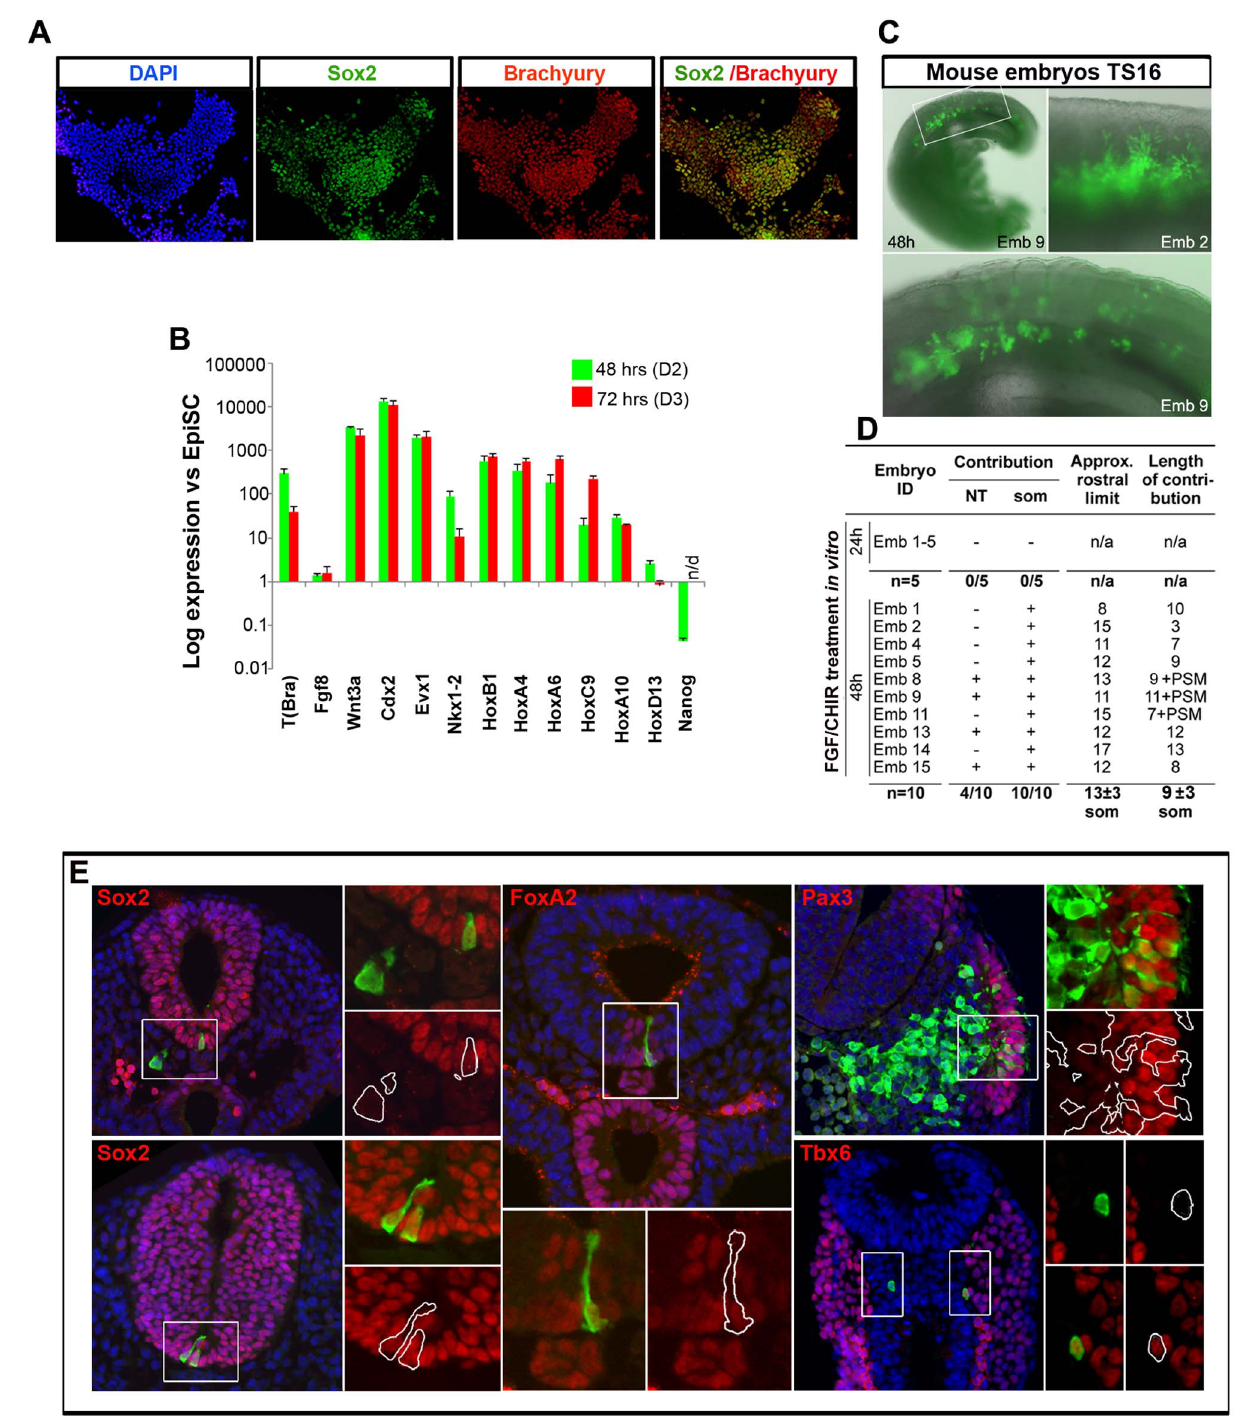
Figure 4. Generation of NMPs from EpiSCs. (A) Brachyury/Sox2 immunocytochemistry in EpiSC cultures treated with FGF/CHIR for 72 h. (B) qPCR analysis for indicated markers in mouse EpiSCs treated with FGF/CHIR. Error bars=s.d. (n=3). n/d, not determined. Results are represented as log 10 ratio of expression versus untreated EpiSCs. The data used to generate the plot can be found in Data S4. (C) Combined fluorescence/brightfield microscopy showing donor cell incorporation of grafted GFP + EpiSC differentiated for 48 h in FGF/CHIR after 48 h embryo culture. (D) Table summarizing the incorporation of grafted GFP + EpiSC differentiated for 24 h or 48 h in Fgf/Wnt within host embryos. NT, neural tube; Som, somite; PSM, presomitic mesoderm; n/a, not applicable. (E) Representative examples of donor cell incorporation (green, GFP) and differentiation (red, immunofluorescence for indicated markers). Cell nuclei were stained with DAPI (blue). White boxes indicate the position of magnified images of GFP + cells.